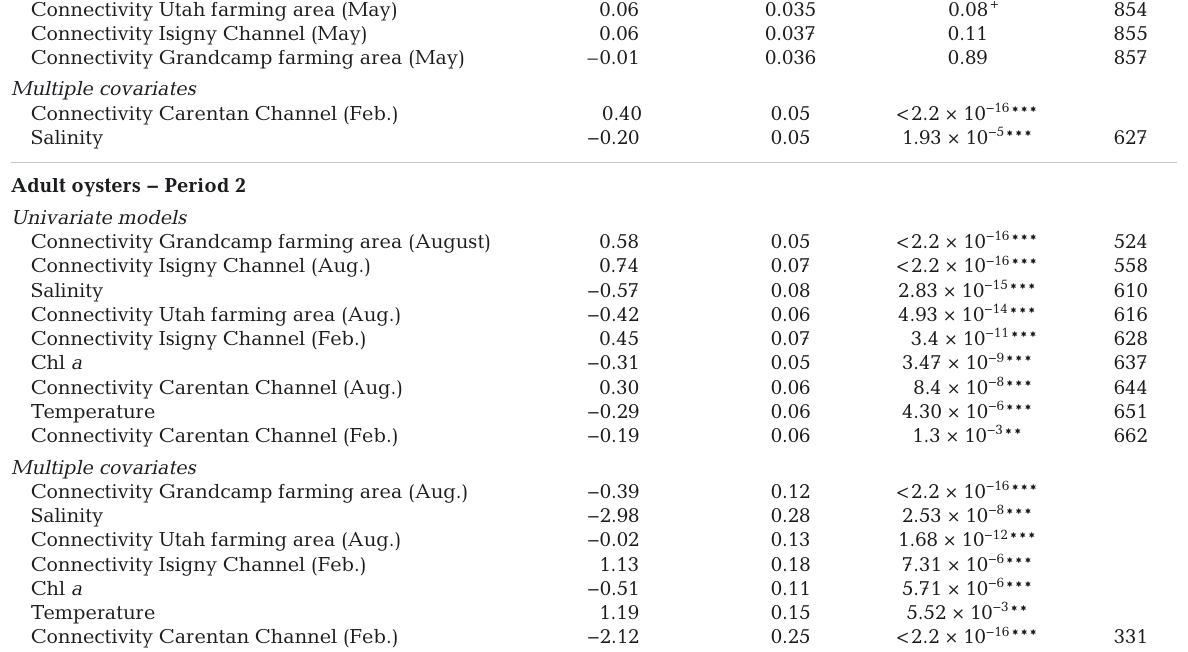
the 2 strongest associated variables) for Period 2. The fits between prediction and observation were moder- ate for Period 1 and good for Period 2 (R 2 = 0.30 and